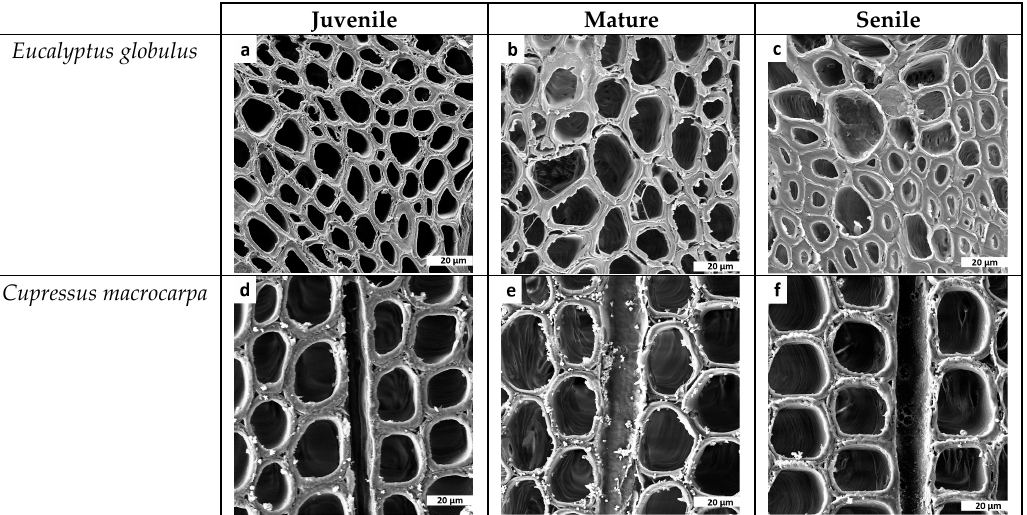
Figure 7. Microphotographs of transverse cuts obtained in SEM for the comparison of green tissue-microstructure transitions in Eucalyptus globulus and Cupressus macrocarpa per age group. Figures ( a ) to ( c ) show the transitions of longitudinal parenchyma cells in Eucalyptus globulus , whereas Figures ( d ) to ( f ) show the transitions of longitudinal tracheids for Cupressus macrocarpa .